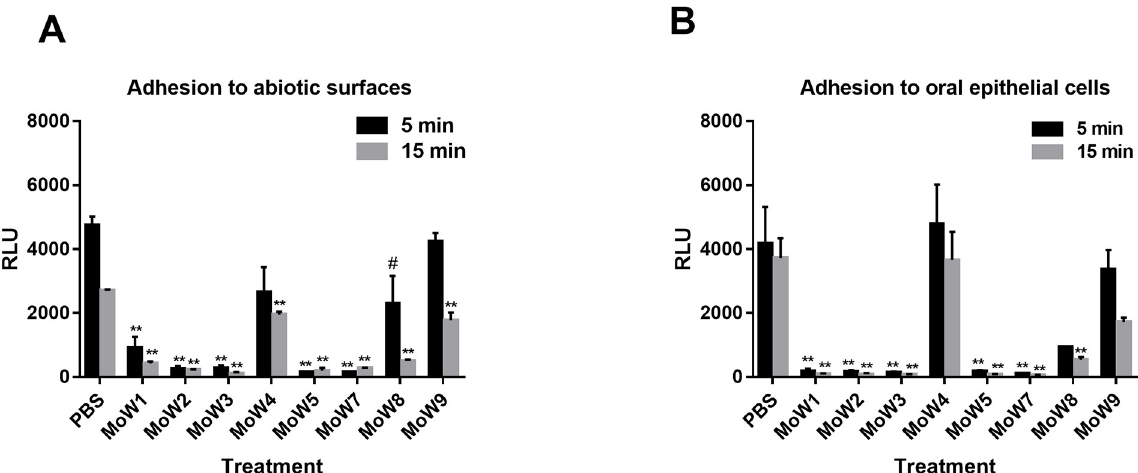
Fig 1. Adhesion of MoWs-treated BLI C . albicans to plastic and epithelial cells. Yeast cells, treated for 5 minutes (black columns) or 15 minutes (grey columns) with MoWs or PBS (as a control), were washed, suspended in cF12 and seeded (1 x 10 5 cells/well) in 96-well plates where they were let adhere for 1 hour at 37˚C. Then, the adhesion to abiotic surfaces (plastic bottom of the well plates— A ) and adhesion to biotic surfaces (TR146-covered bottom of the well plates— B ) were assessed by bioluminescence. Signals collected are expressed as relative luminescence units (RLU). The results are mean values ± standard errors of triplicates. # p < 0.05 or �� p < 0.001 indicate significant differences between MoWs-treated vs PBS-treated BLI C . albicans . MoW1: Curasept 0.20; MoW2: Dentosan Collutorio; MoW3: Meridol Collutorio; MoW4: Elmex Sensitive Professional; MoW5: Listerine Total Care Zero; MoW7: Parodontax; MoW8: Oral B; MoW9: PlaKKontrol Protezione Totale.